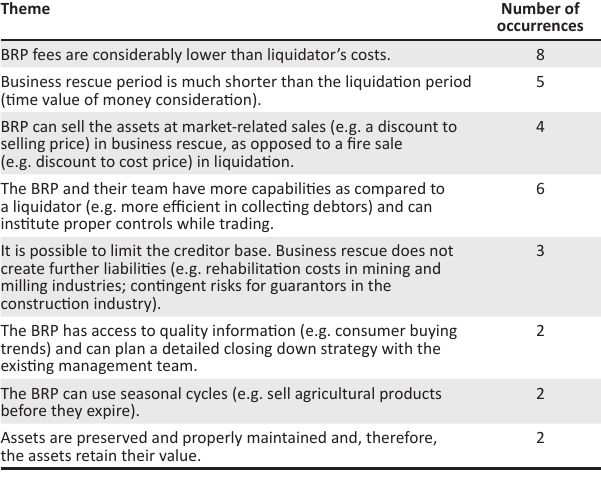
TABLE 2: How the business rescue practitioner creates value through a controlled